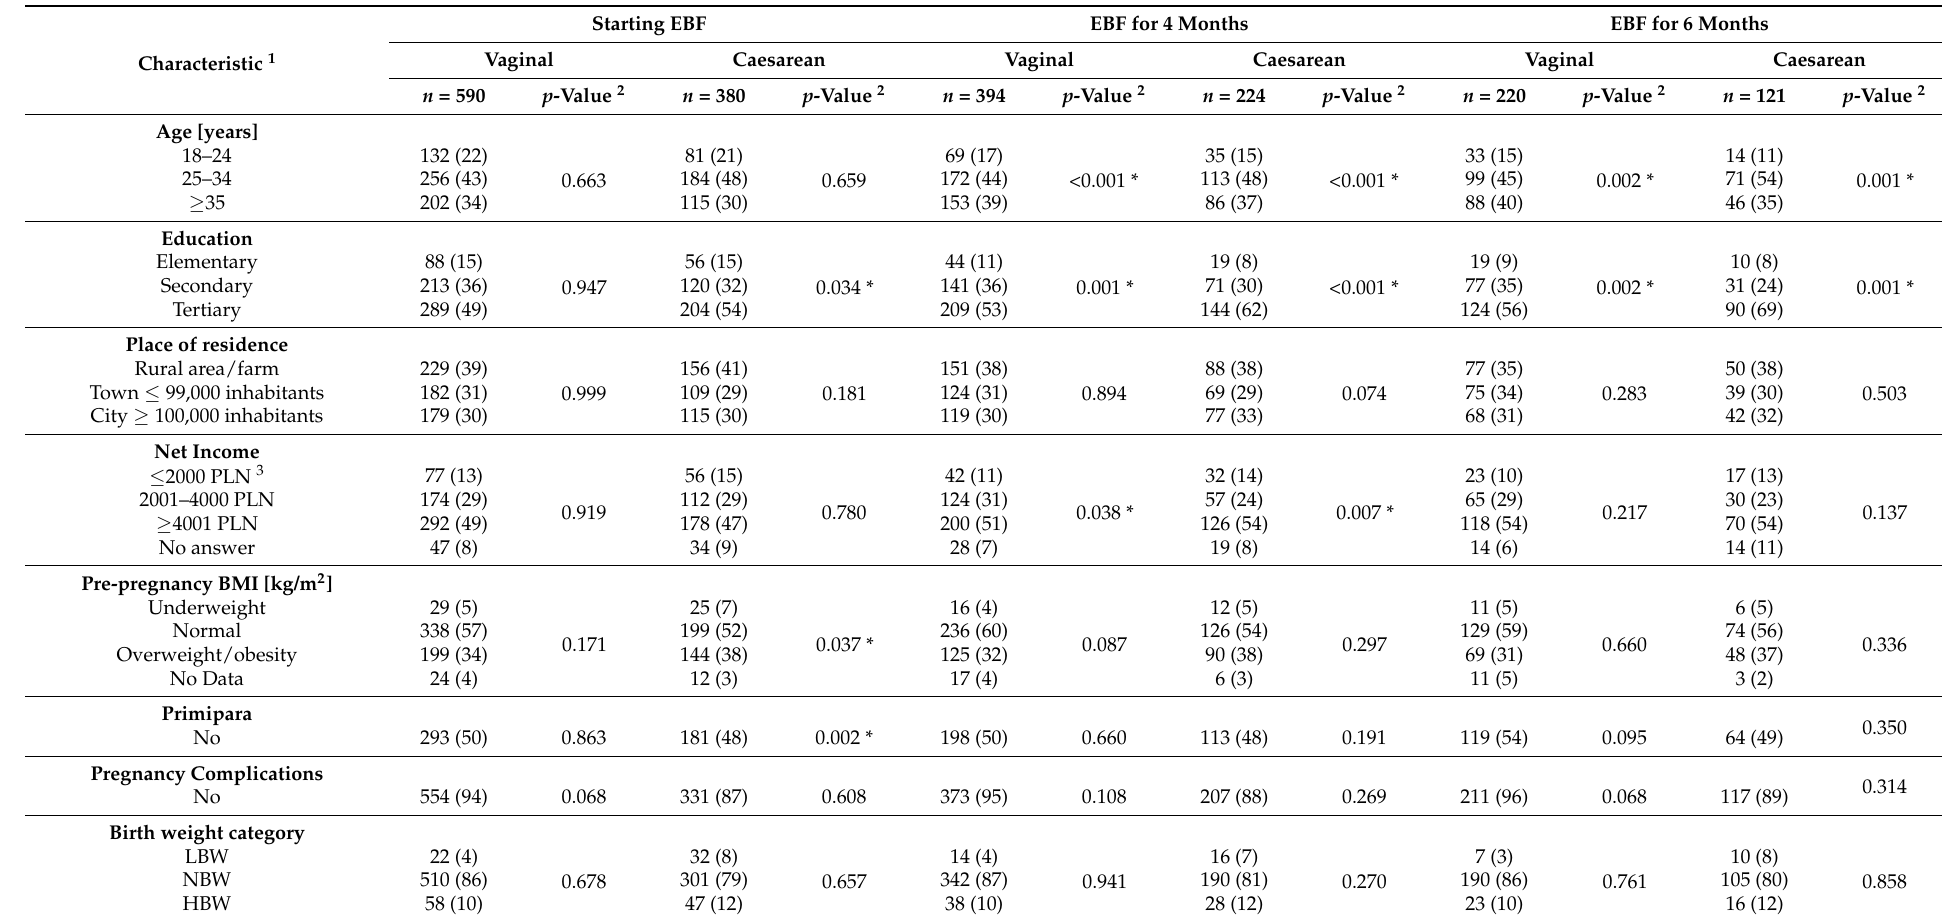
Table 3. Factors associated with exclusive breastfeeding (EBF) practice depending on the method of delivery ( n =